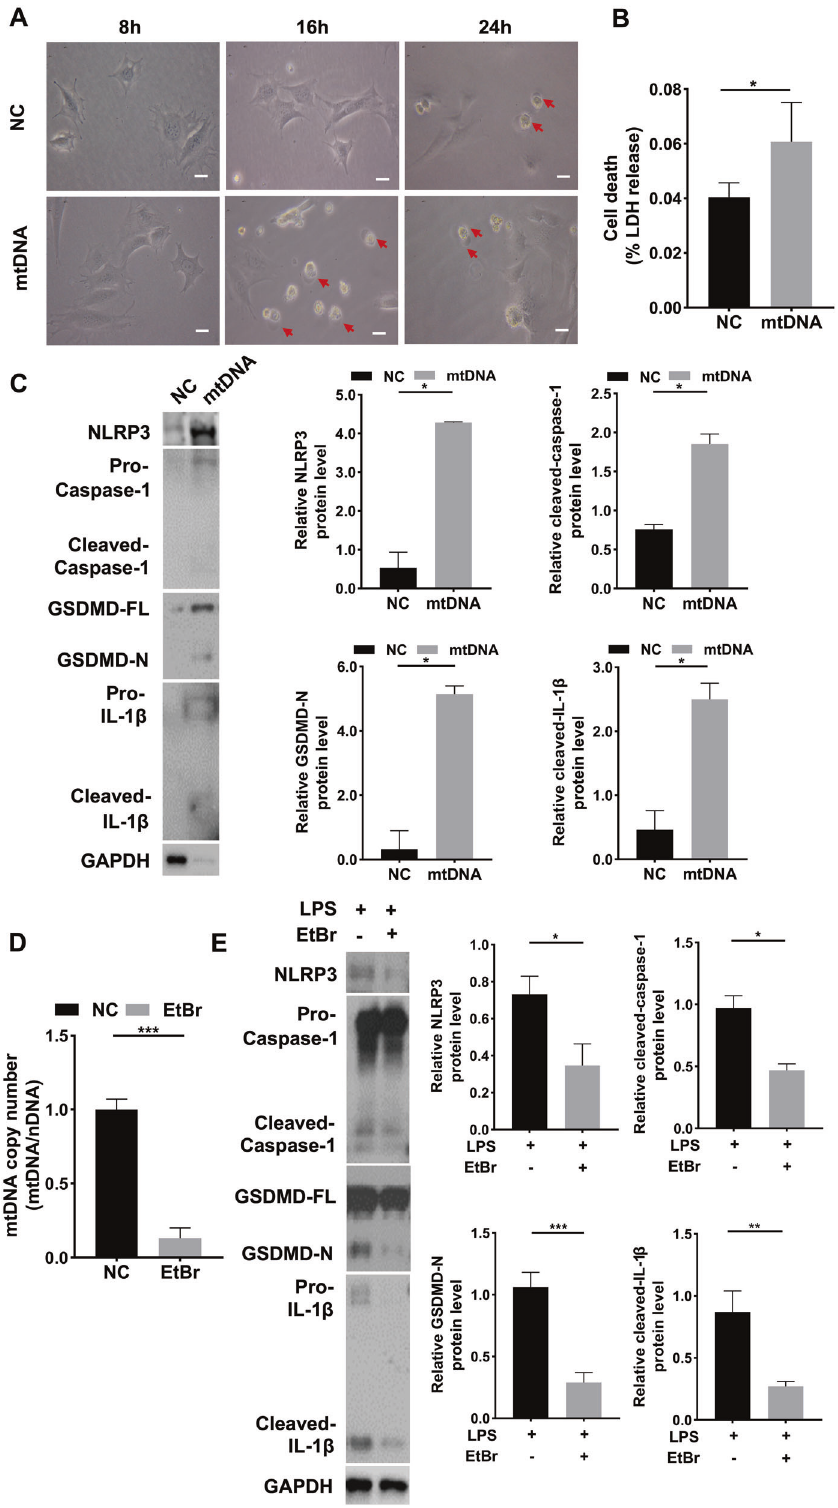
Fig. 3 Cytosolic mtDNA induced mDPC6T pyroptosis. A Light microscopy examined the mDPC6T cells pyroptosis phenotype after transfected mtDNA (scale bar, 50 μ m). B LDH release assay was used to detect cell death after overexpression of mtDNA in mPDC6T cells (1 μ g/ well, 24 h). C The protein level of NLRP3, Caspase-1, GSDMD and IL-1 β in mDPC6T cells was measured by western blotting after transfected mtDNA. D qPCR was performed to assess the mtDNA copy number in mDPC6T cells after EtBr treatment (1 μ g/ml, 48 h). E The protein level of NLRP3, Caspase-1, GSDMD and IL-1 β in mDPC6T cells after treatment with LPS and EtBr examined by immunoblotting. The data are the means ± standard deviations of 3 independent experiments ( p < 0.05 * , p < 0.01 ** , p < 0.001 *** ).